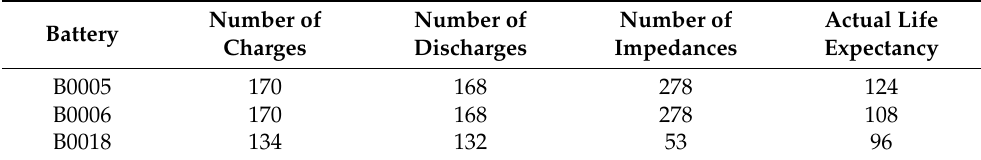
Table 1. NASA dataset lithium-ion battery information.